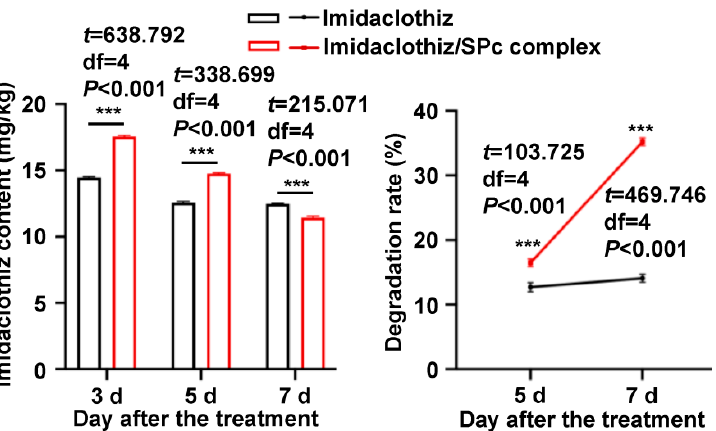
Figure 6. Residue and degradation rate of SPc-loaded imidaclothiz in tobacco plants. Five-leaf stage tobacco plants were immersed in imidaclothiz or imidaclothiz/SPc complex solution for 1 min, and collected on 3, 5 and 7 d after the immersion for liquid chromatography-tandem mass spectrometry (LC-MS/MS) analysis. Each treatment contained 3 independent samples. The “***” indicates significant differences according to the independent t test ( p < 0.001).